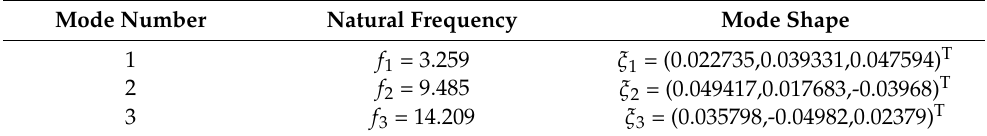
Figure 7. Experimental model of a three-floor steel frame structure. ( a ) Schematic diagram of the experimental structure in reference [32]; ( b ) Damage case 1: notch by cutting from 75 to 51.3 mm in the first floor; ( c ) Damage case 2: notches by cutting from 75 to 37.46 mm in the first and second floors; ( d ) Geometric size of the experimental structure. Table 6. Experimental modal data for the undamaged structure. Table 7. Experimental modal data for damage case 1 (the first floor is damaged by 11.6% stiffness reduction).